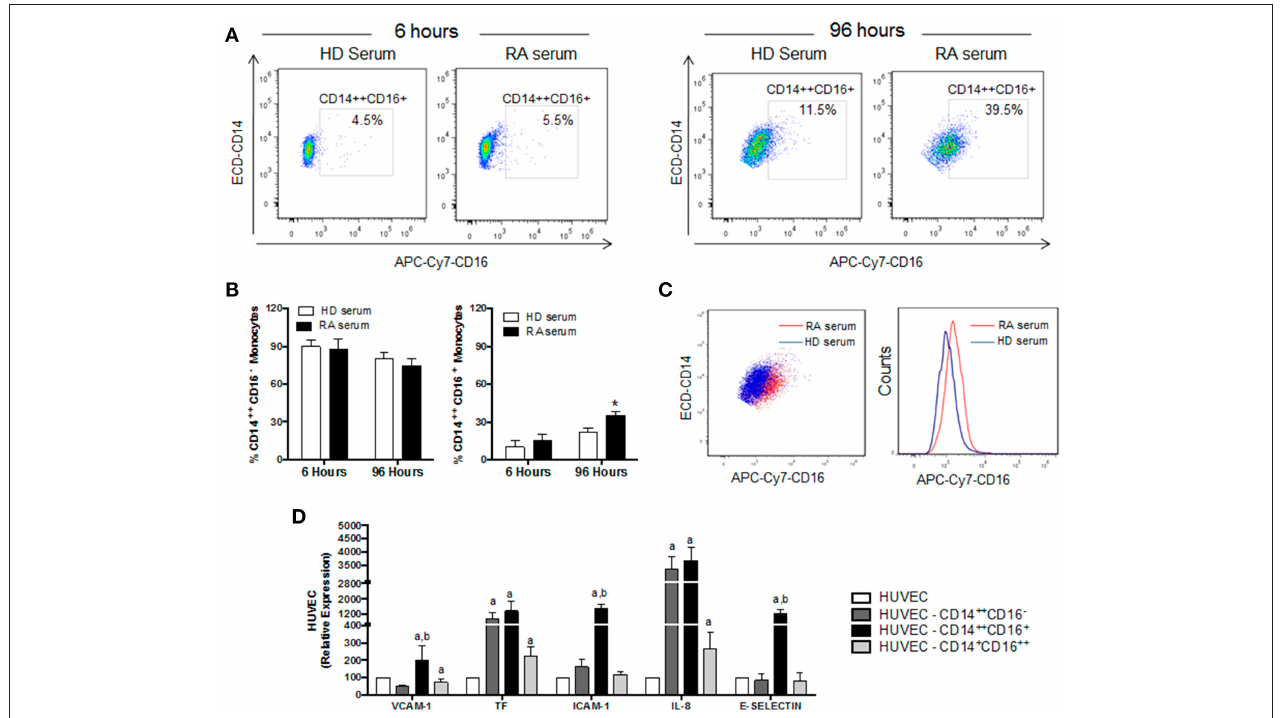
FIGURE 9 | In vitro RA serum promoted the differentiation to CD16 + monocytes and the activation of endothelial cells. (A) Representative dot plot of intermediate monocytes of CD14 + monocytes isolated from HDs and treated with serum (10%) of HDs and RA patients for 6 and 96h. (B) Percentage of classical monocytes (CD14 ++ CD16 − ) and intermediate monocytes (CD14 ++ CD16 + ) after in vitro treatment of CD14 + monocytes isolated from HDs treated with serum (10%) of HDs and RA patients for 6 and 96h. Data represent mean ± SEM of five independent experiments. Paired t -test was performed *indicates significant differences vs. CD14 + HD monocytes treated with HD serum ( p < 0.05). (C) Representative overlay dot plot and histogram showing the generation of intermediate monocytes after treatment of CD14 + HD monocytes with serum from RA patients. (D) mRNA relative expression of genes involved in inflammation, cellular adhesion and coagulation in HUVECs co-cultured with the different monocyte subsets isolated from RA patients for 24h. Data represent mean ± SEM of five independent experiments. Kruskal-Wallis test, followed by a Dunn’s multiple comparison test was performed. a indicates significant differences vs. HUVECs cultured alone, b indicates significant differences vs. HUVECs cultured with classical RA monocytes (CD14 ++ CD16 + ) HD ( p <